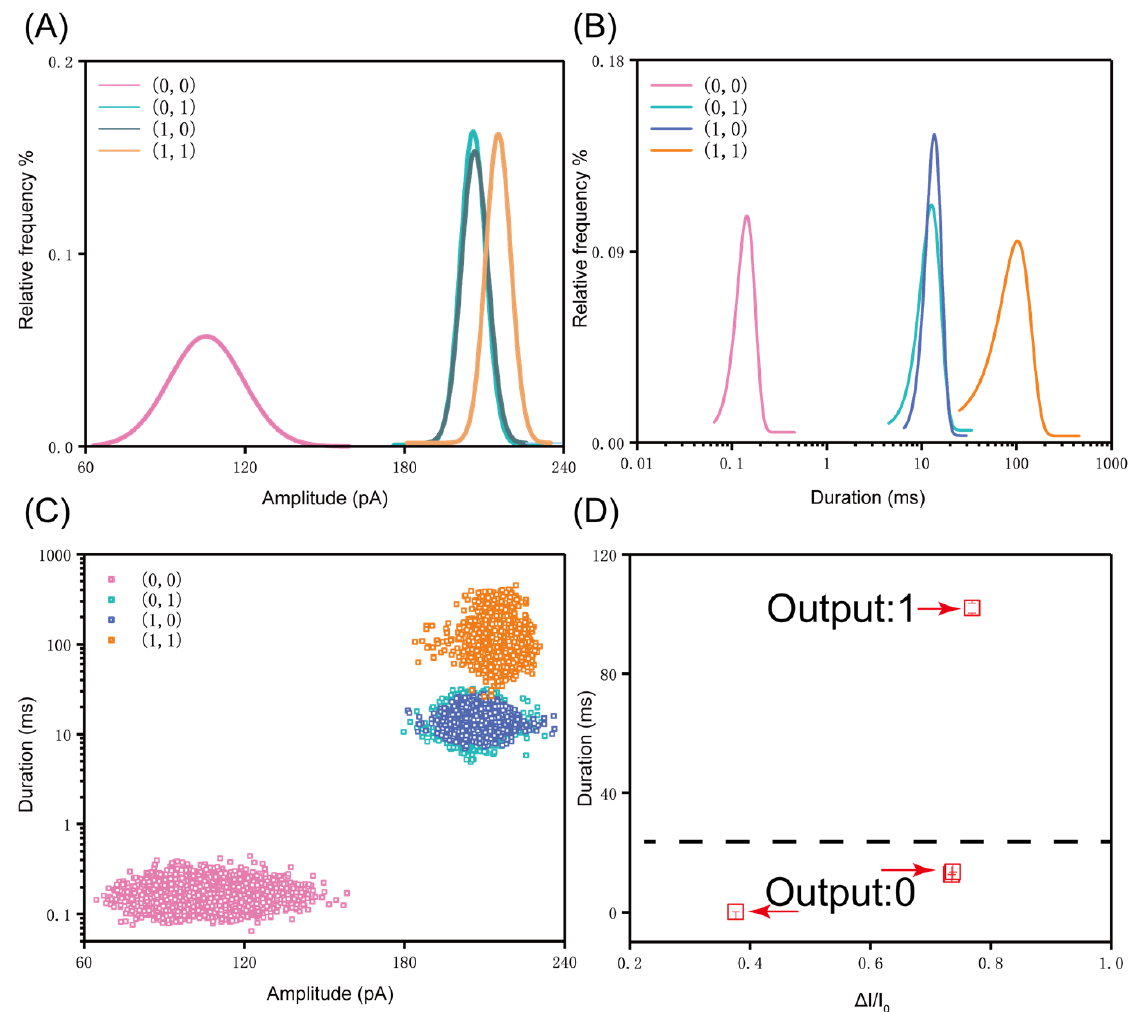
Figure 5. ( A , B ) The comparison curve of amplitude and translocation time, the curves are the Gaussian fitting curve obtained from each group of histograms; ( C ) Represents the scatter plot of duration vs. amplitude for four operation patterns under a voltage of 100 mV; ( D ) The dot plot of average duration and normalized amplitude. The figure shows the results of two logical operations (0 and 1).